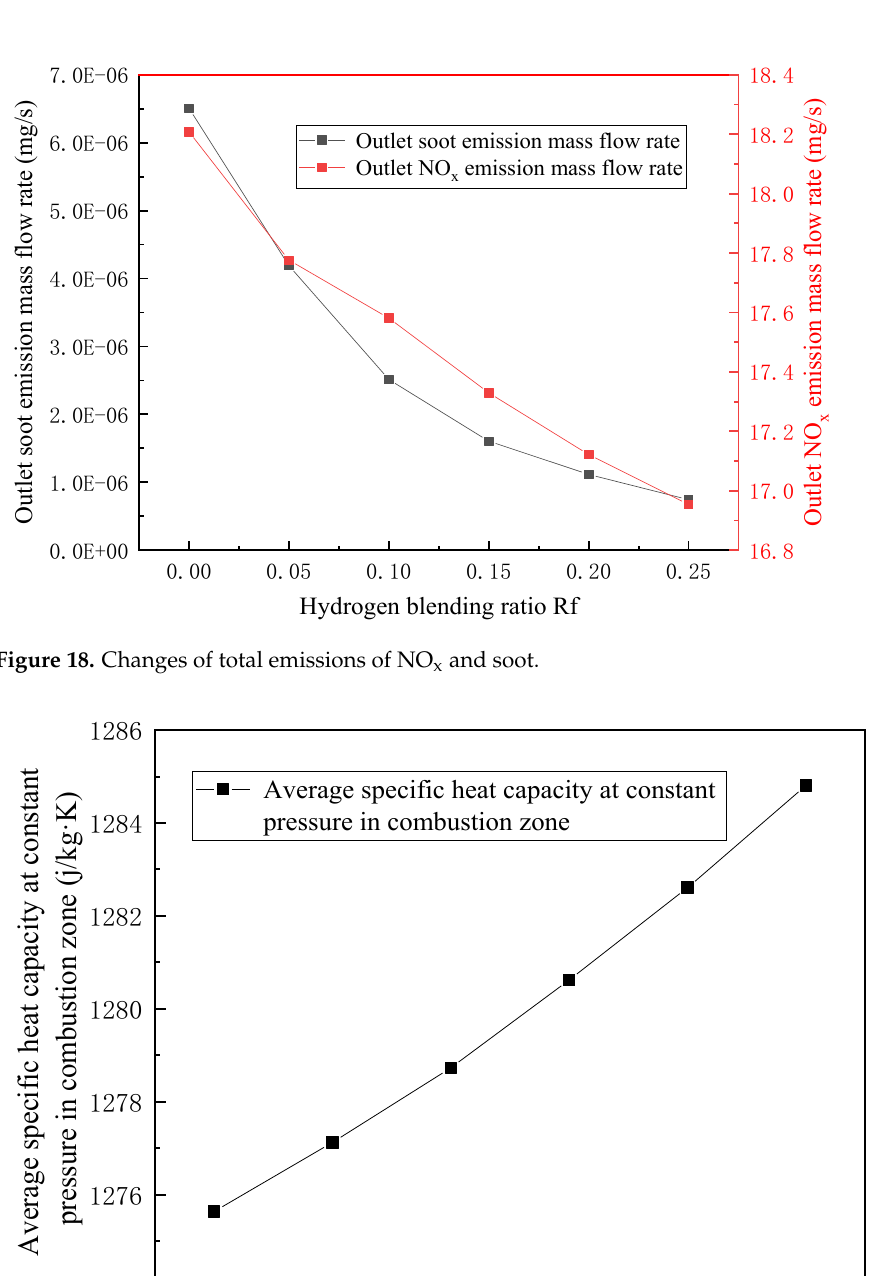
Figure 19. Average specific heat capacity at constant pressure in the combustion zone.